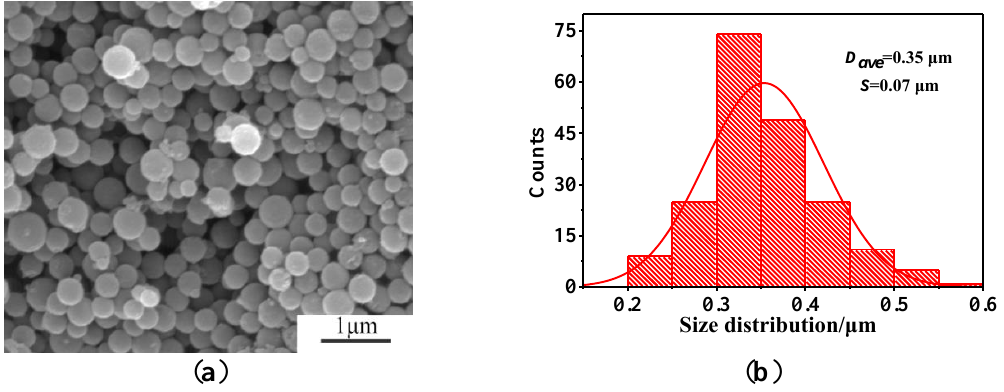
Figure 7. ( a ) SEM image and ( b ) particle size distribution of HGCS prepared at 900 °C for 3 h with 1.0 wt % Fe catalyst.